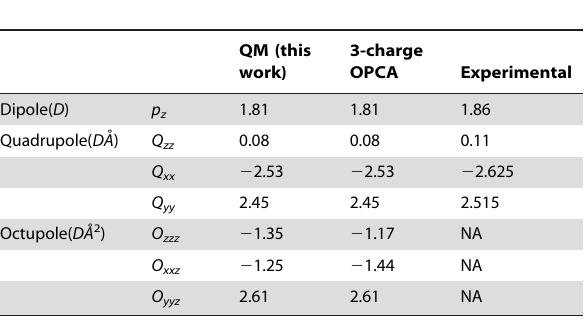
Table 1. Multipole moments of a water molecule in the gas